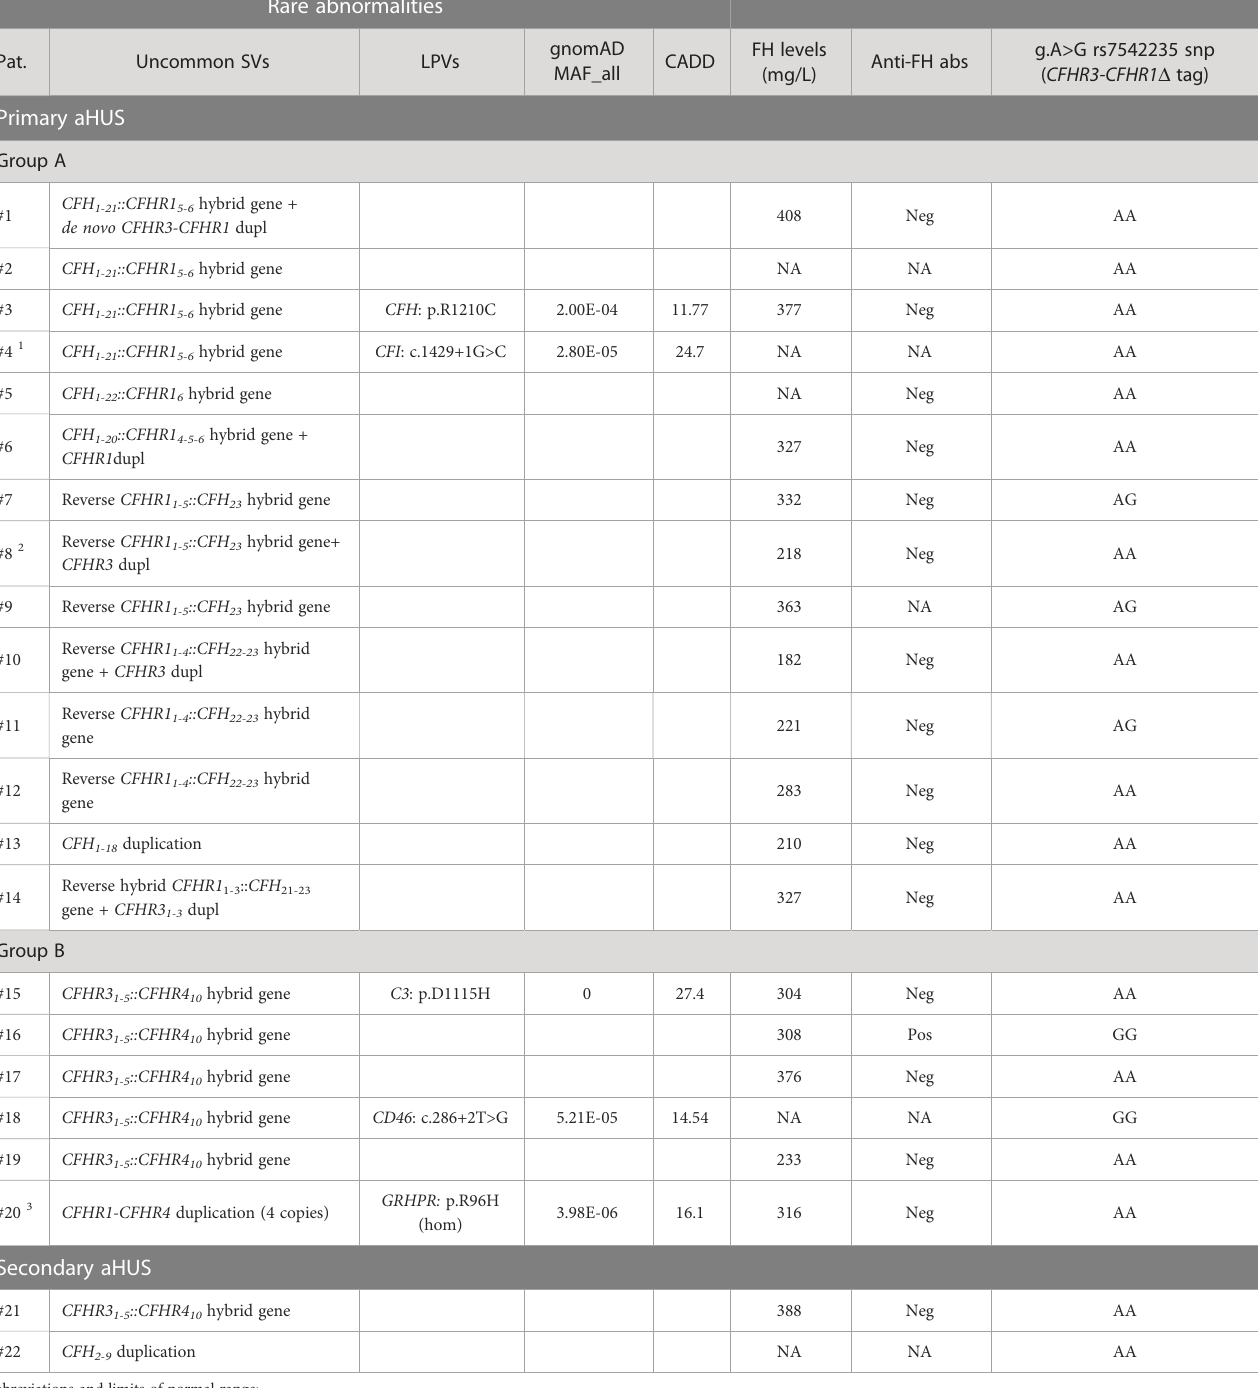
Abbreviations and limits of normal range: SVs, structural variants de fi ned as genomic rearrangements resulting in duplications, deletions and inversions larger than 1 kb; NA, not available; Normal serum/plasma FH levels: ≥ 193 mg/L; LPV,likelypathogenicvariants,de fi nedasgeneticvariantsincodingandsplicingregionsofcomplementgenes( CFH,CFI,CD46,CFB,C3, and THBD )withMAF<0.001inthegnomADDatabaseand with a CADD phred score ≥